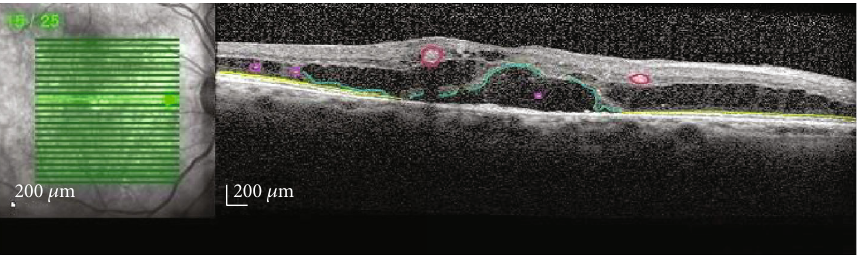
Figure 6: Highlighted OCT image showing HF, hard exudates, and the disruption of IS/OS photoreceptor segments (EZ).